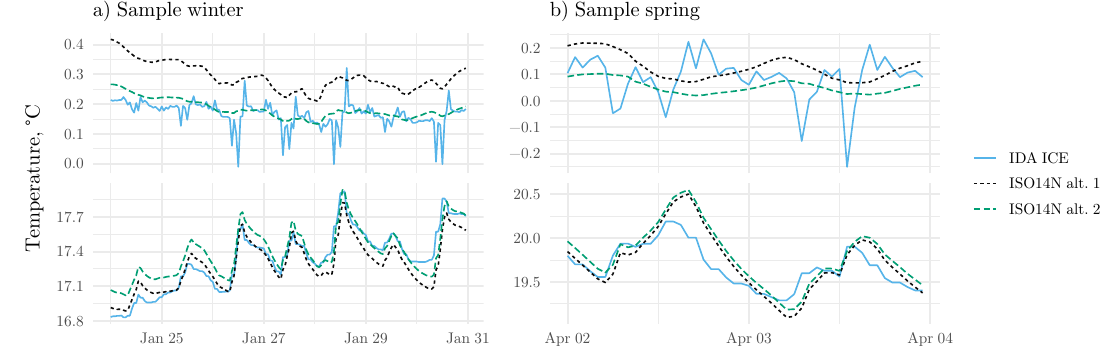
Figure 5. Comparison with IDA ICE on operative temperatures for two sample periods. The bottom row shows operative temperatures ( θ op ) and the upper row shows the temperature difference between internal air temperature and operative temperatures ( θ int − θ op ).